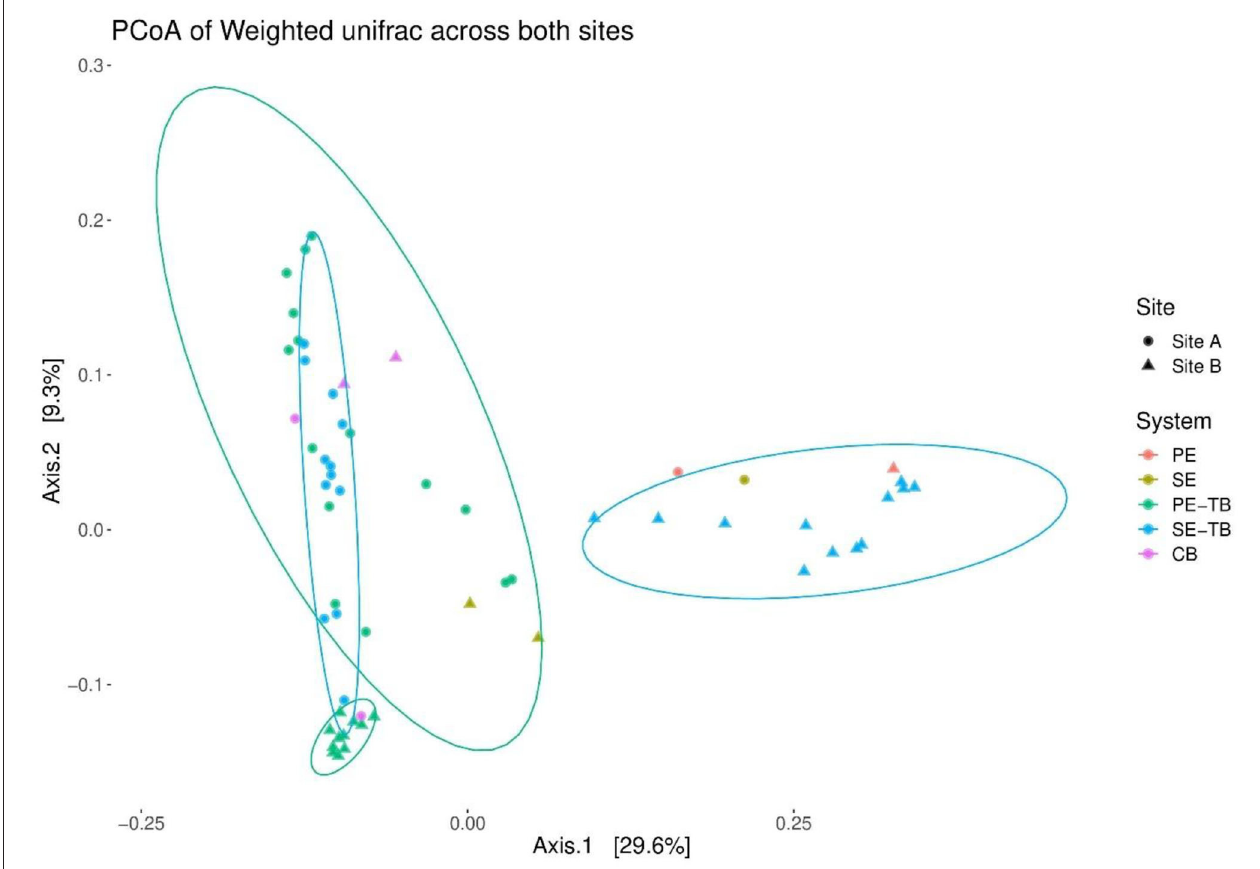
FIGURE 6 | Principal coordinates of beta diversity based on weighted Unifrac distances within STUs at both sites. Each data point represents a sample taken from either PE effluent stream, SE effluent stream, or control soils. Samples are further subdivided based on the position within the system, i.e., at the STU; base, top, and control; base, top, and pure effluent samples.